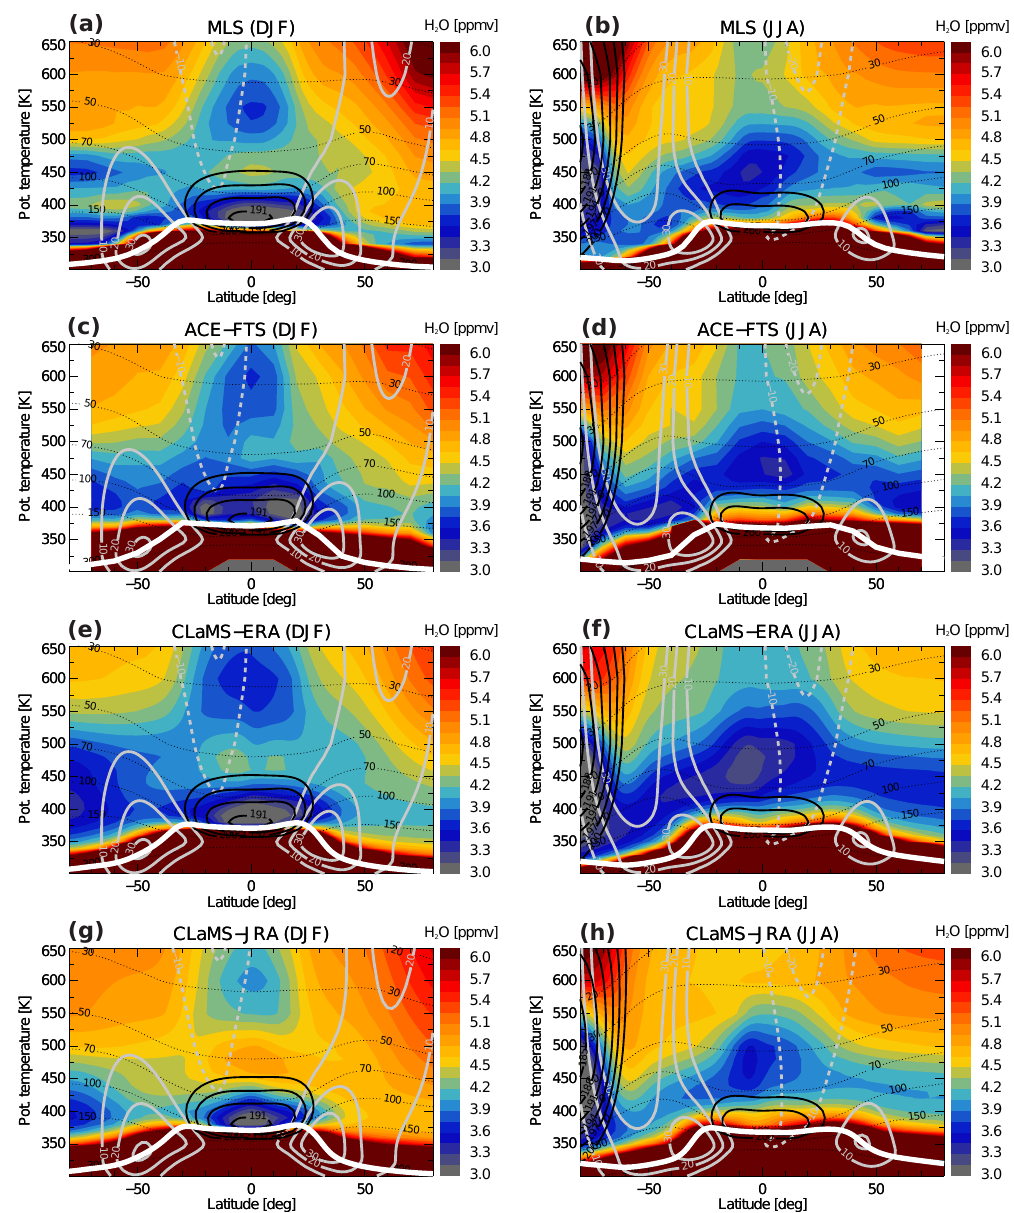
Figure 3. Zonal mean water vapour distributions for winter (DJF, left) and summer (JJA, right) from MLS and ACE-FTS satellite obser- vations, as well as for CLaMS simulations driven with either ERA-Interim or JRA-55. Data shown are climatologies for 2004–2013 years. Black contours show temperatures (185, 188, 191, 194, 197, 200K), grey contours are zonal winds (10, 20, 30ms − 1 ), black dotted lines are pressure levels (in hPa) and the white line is the thermal tropopause. Note that the temperatures, zonal winds and pressure level contours are derived at the (a, b) and (c, d) from ERA-Interim sampled at the MLS or ACE-FTS locations respectively (e, f) are from ERA-Interim and (g, h) are from